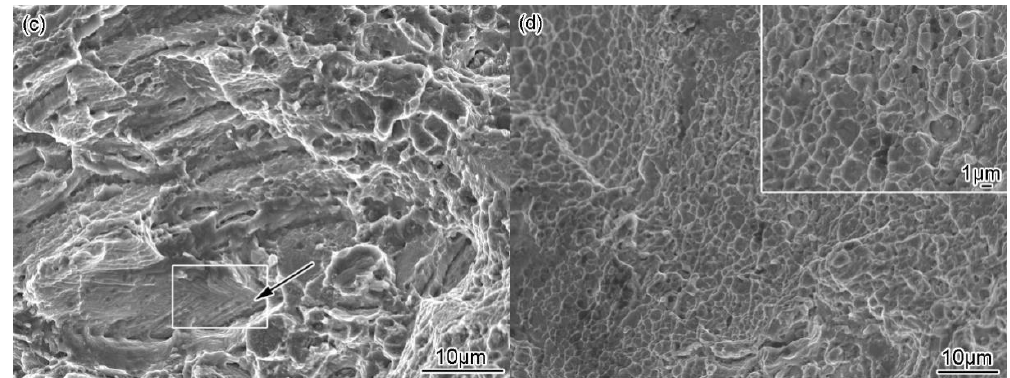
Figure 6. Fracture morphology of IFed alloy after creep at 705 °C/897 MPa: ( a ) low magnification morphology, ( b ) the fracture source region, ( c ) the propagation region, the arrow shows small steps with deep interlaced slip traces, and ( d ) the shear lip region.